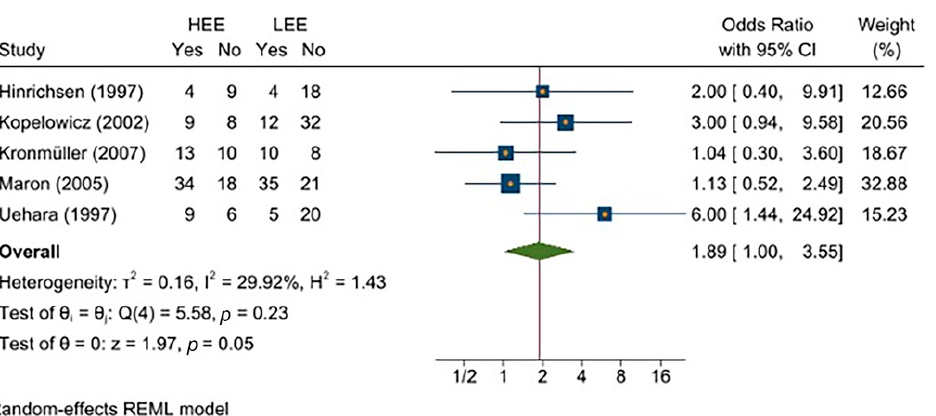
Figure 2. Forest plot of the meta ‐ analysis with all six studies included [35,37–41].